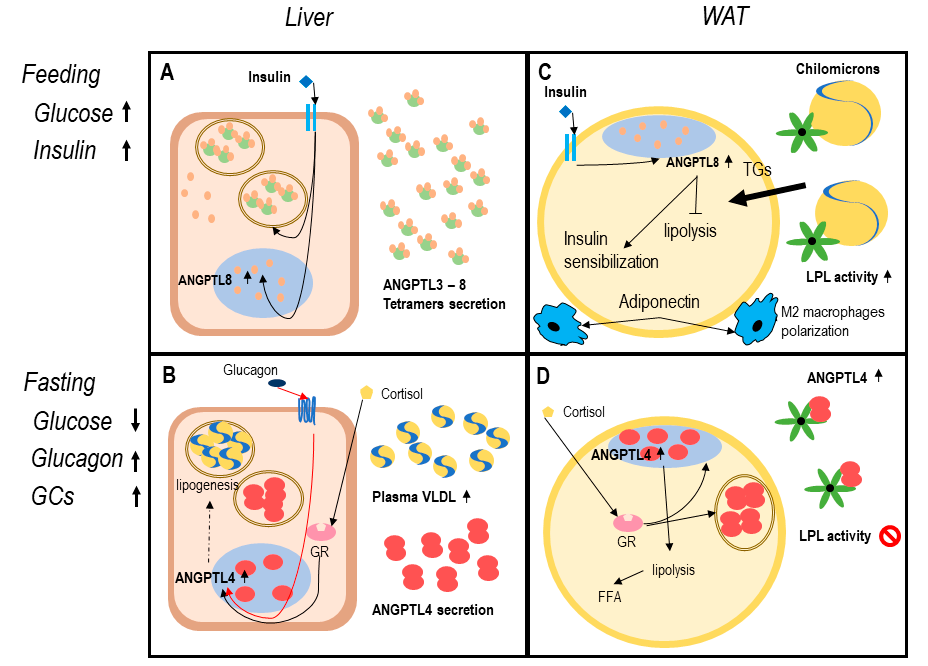
Figure 1. The angiopoietin-like system (ANGPTLs) model in healthy adipose tissue. Legend: functioning of ANGPTL system in healthy adipose tissue. Dotted lines report data with a low level of evidence. Panels ( A , B ) describe the hepatocyte function in feeding and fasting. In response to insulin increase ( A ), hepatocytes secrete ANGPTL8, and ANGPTL3. ANGPTL3-8 tetramers inhibit lipoprotein lipase (LPL) in oxidative tissues [7,68]. Reduced blood glucose in fasting ( B ) leads to increased circulating glucocorticoids and glucagon that induce ANGPTL4 expression [82,94]. In the liver, ANGPTL4 expression possibly enhances lipogenesis and gluconeogenesis, VLDL production, and secretion, as proved in mouse models [89]. Panels ( C , D ) describe white adipocyte function in feeding and fasting. During feeding ( C ), insulin enhances nuclear expression of ANGPTL8 determining a block in lipolysis and enhanced insulin sensibilization, adiponectin secretion, and M2 polarization of resident macrophages [67,68,71]. In fasting ( D ) ANGPTL4 is expressed both in nucleoplasm and secreted [74,75,84,86,94]. In this physiologic condition, lipolysis is functional to liberate free fatty acids (FFA) deposit and promotes energy utilization [7,81,89].